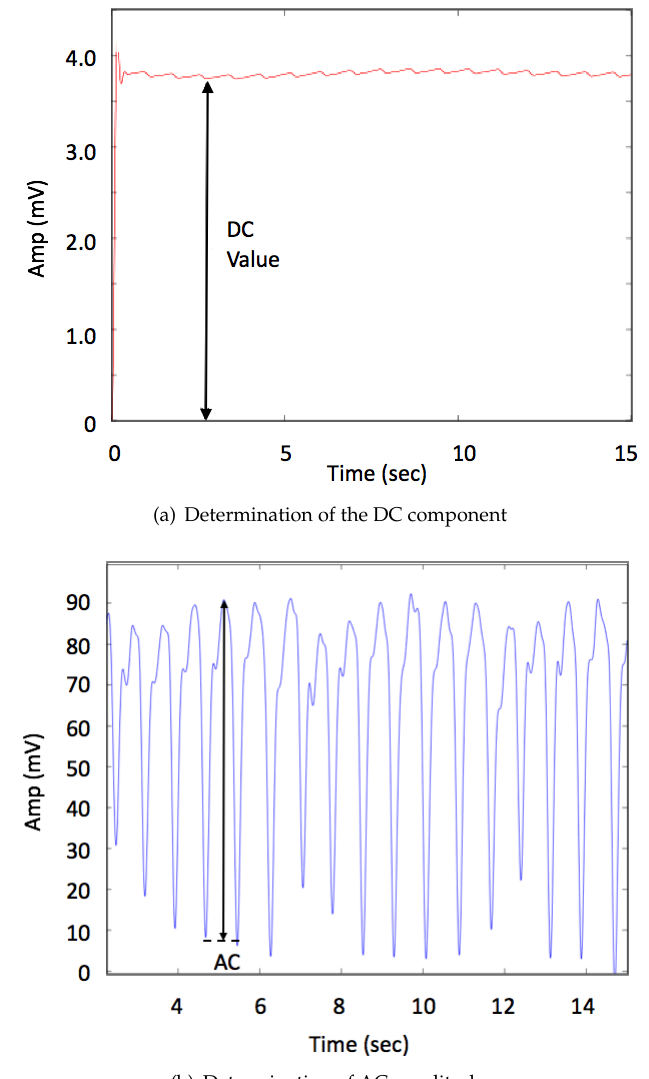
Figure 4. Measurement of PPG signals to extract the DC and AC components. ( a ) the raw data contains both information of non-pulsatile (DC) and a relatively small variation resulting from pulsatile (AC) absorption; ( b ) filtering of the raw data can be used obtain the dynamic AC